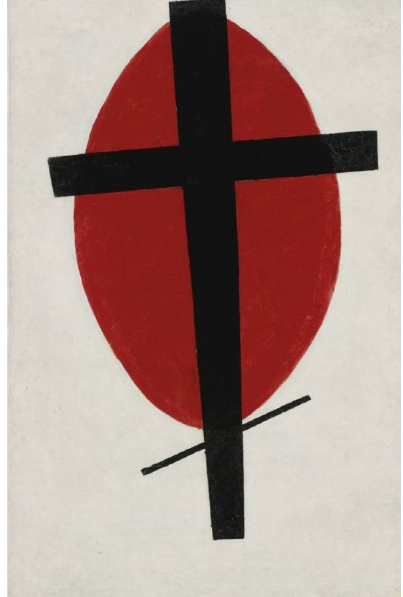
Figure 1. Mystic Suprematism (Black Cross on Red Oval) , 1920–1922. The collection of the Stedelijk Museum of Amsterdam. © Stedelijk Museum.